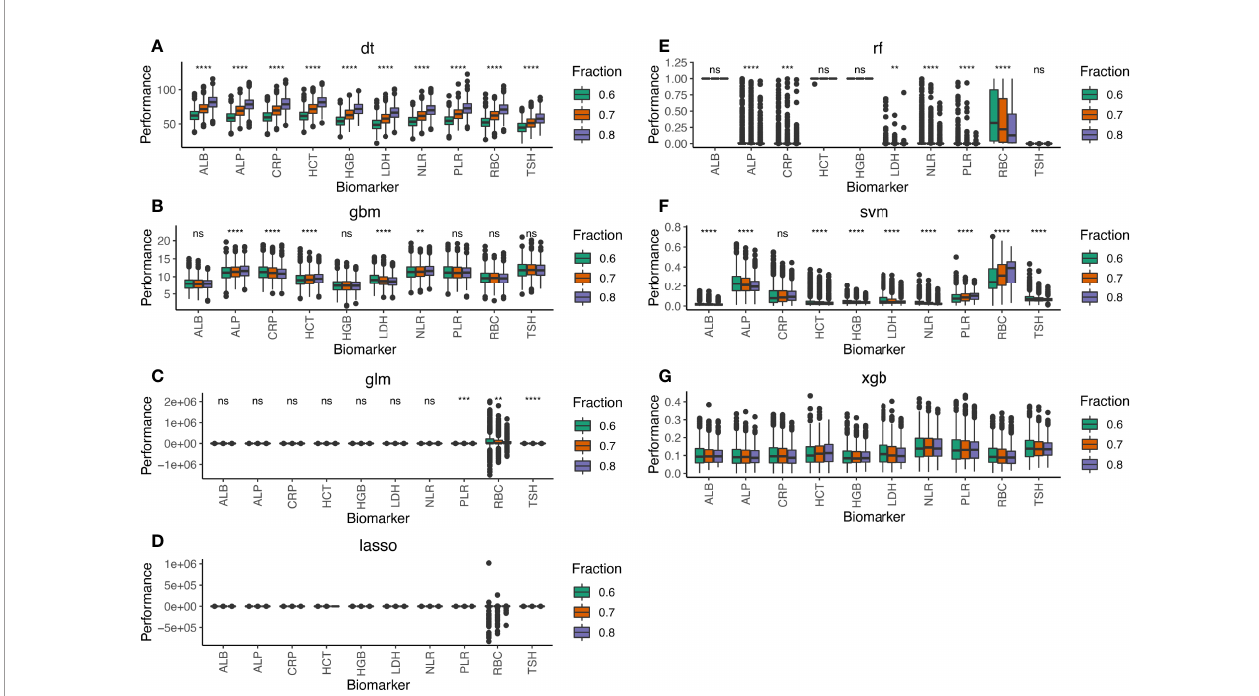
FIGURE 2 | Performance of the 10-biomarker panel evaluated by the seven machine learning methods of (A) DT, (B) GBM, (C) GLM, (D) LASSO, (E) RF, (F) SVM, and (G) XGB. Performance scores were computed by each machine learning method for 1,000 simulations of the training and test datasets at 8:2, 7:3, and 6:4 cohort ratios randomly selected from the combined cohort comprising 1,320 atezolizumab-treated and whisker plot shows the median (thick black line in the middle of the box), the interquartile range between 75% and 25% (upper and lower end of the box), and 1.5 multiplied by upper or lower interquartile range (whiskers), respectively. ns is P ≥ 0.05, *P < 0.05, **P < 0.01, *** P < 0.001, ****P <